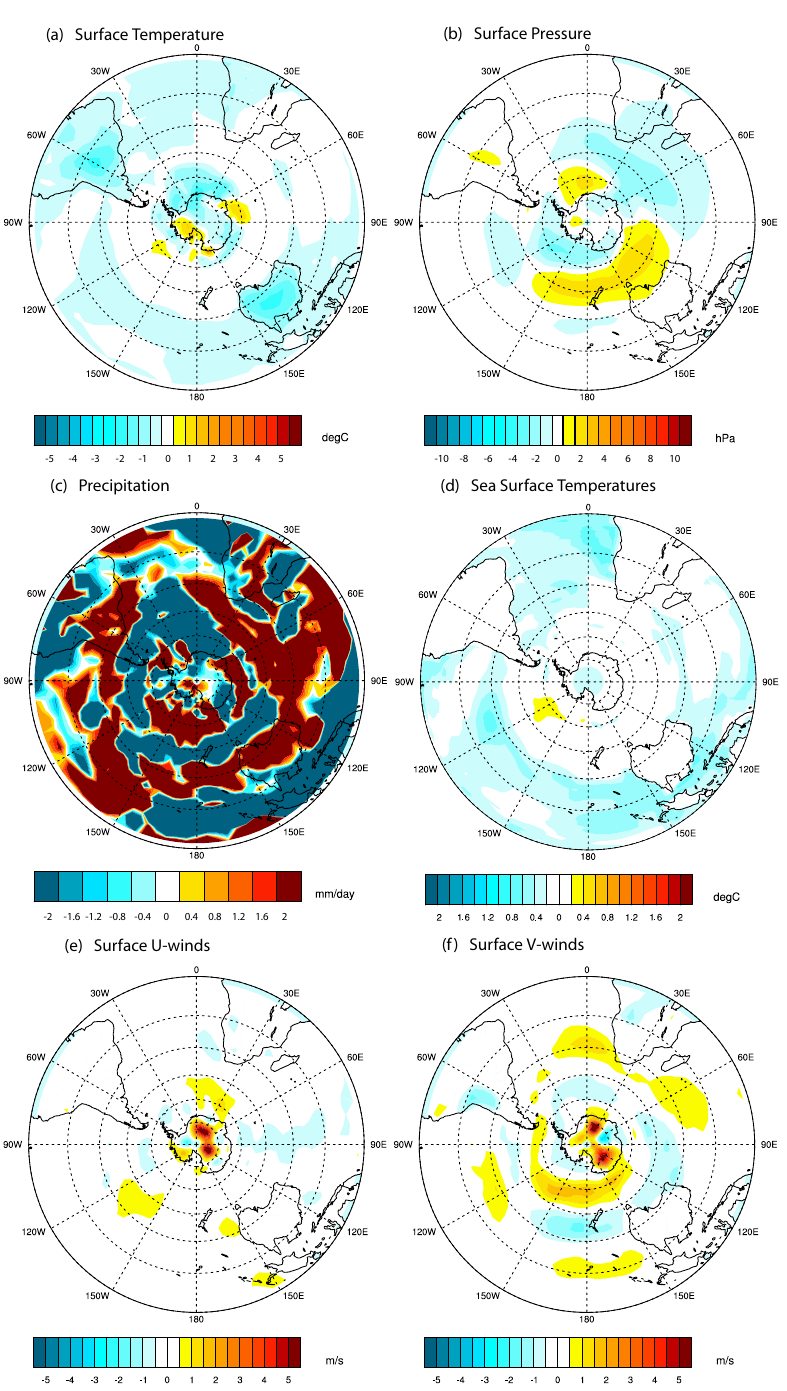
Fig. 8. Regression coefficients between the volcanic forcing and the changes in (a) surface temperature, (b) surface pressure, (c) precipitation, (d) sea surface temperature, (e) zonal surface wind (denoted as U -winds) and (f) meridional surface winds (denoted as V -winds) shown as responses to a change in aerosols by 1 optical depth unit for year 1 after the eruption.